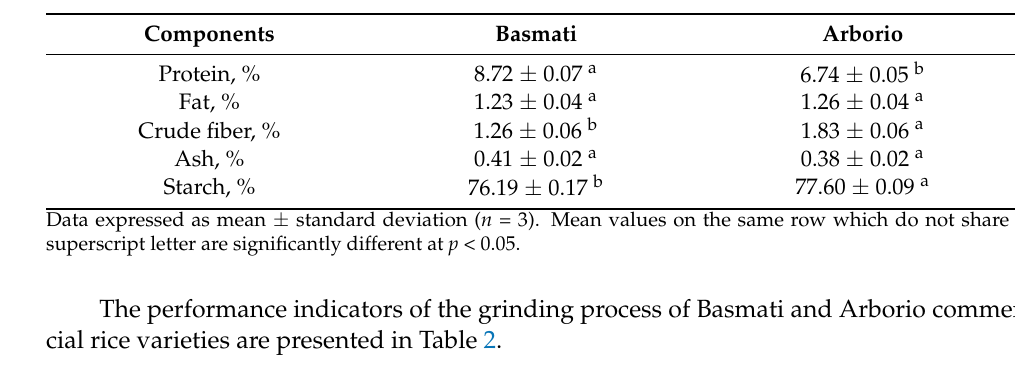
Table 2. Influence of rice freezing on the performance of grinding process.